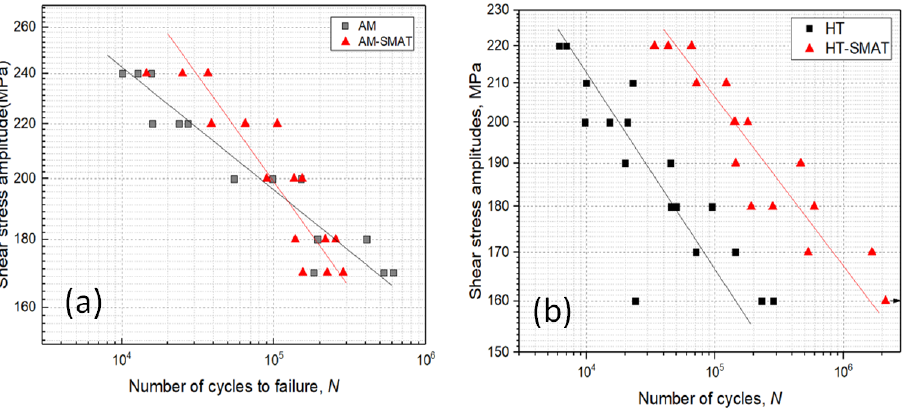
Figure 3. S–N plots of experimental torsional fatigue data for ( a ) AM and AM-SMAT samples, and ( b ) HT and HT-SMAT samples. S–N curves built from the Basquin equation (black and red lines) are also plotted.